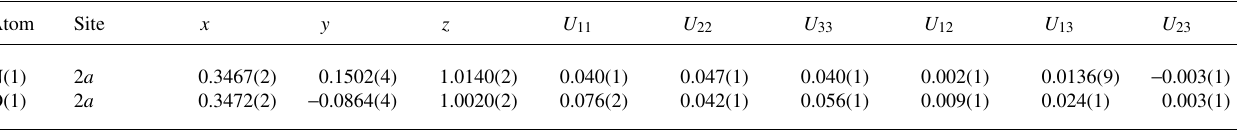
Table 3. Atomic coordinates and displacement parameters (in Å 2 )